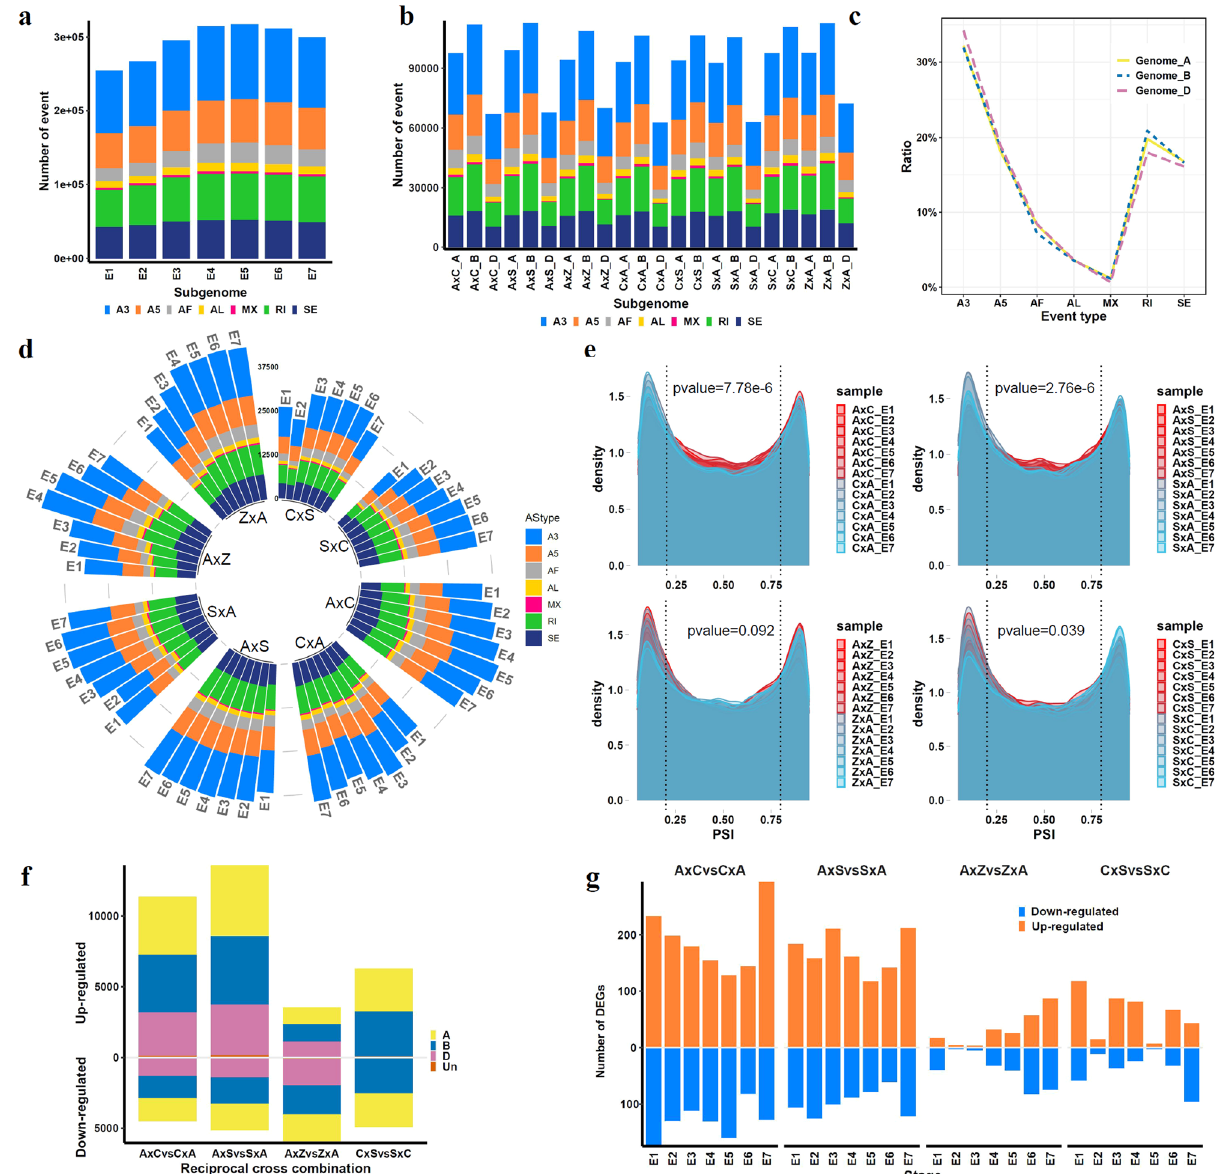
Fig. 4 Interspeci fi c hybridization resulted in altered AS pattern. a Number of AS events identi fi ed at each stage in embryos. b Subgenome distribution of AS events in all embryo stages for each cross. c Ratio of each AS type on A, B, and D genome. d Number of AS events in reciprocal pairs. e Density of psi values in reciprocal pairs at embryo stages. Statistical signi fi cance between each cross pair is calculated by Kolmogorov – Smirnov test. f Number of differential AS between reciprocal cross pairs. A, A genome; B, B genome; D, D genome; Un, unknown. g Number of DEGs involved in splicing regulation between reciprocal pairs. Number of upregulated genes and downregulated genes involved in splicing pathways are